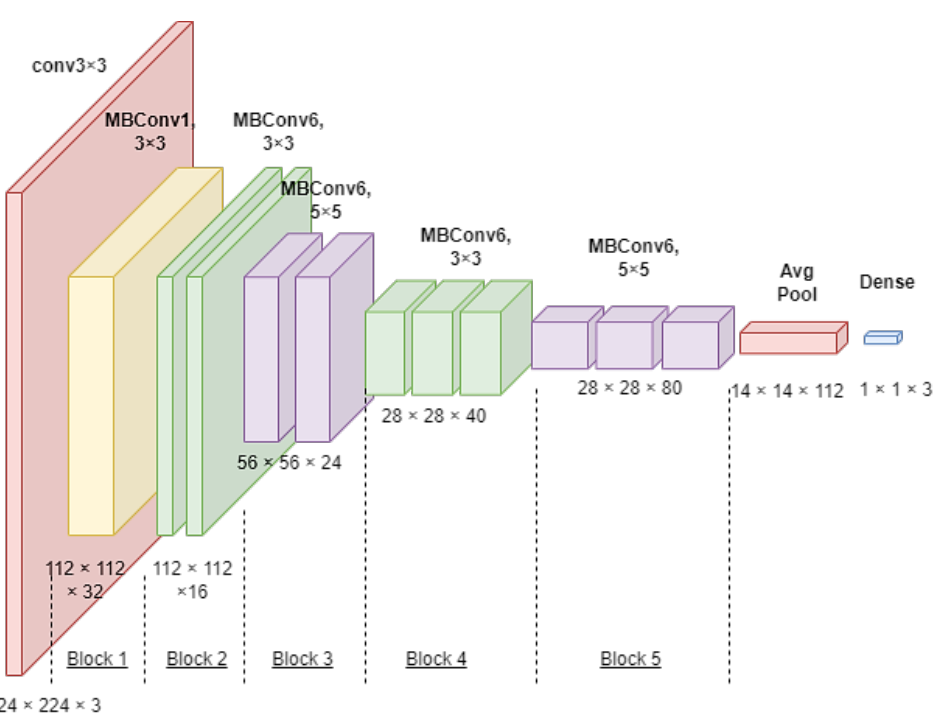
Figure 4. Efficient-ME network